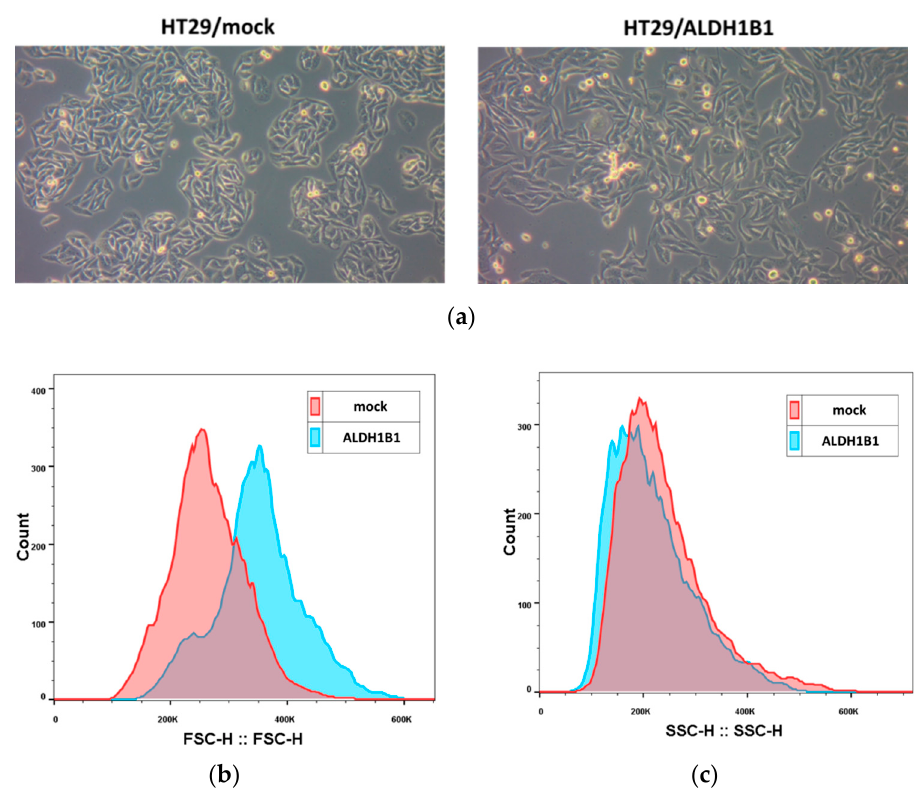
Figure 2. Expression of ALDH1B1 triggers significant morphological alterations in HT29 cells. ( a ) Photographs of the HT29 isogenic cell line pair demonstrating the morphological differences under optical microscopy (magnification 20×). ALDH1B1-overexpressing cells have different sizes ( b ) and granularity ( c ) compared to mock control cells. At least 20,000 events were analyzed through flow cytometry, and the median fluorescence intensity of forward scatter (FCS) and side scatter (SSC) parameters was determined in both cell lines (Table 2). Representative histograms of FSC ( b ) and SSC ( c ) of the HT29 isogenic cell line pair. The HT29/ALDH1B1 histogram (light blue color) had appreciably right-shifted forward and left-shifted side scatter, demonstrating the bigger size and lower granularity of ALDH1B1-overexpressing cells in comparison to HT29/mock cells (pink color). Graphs are representative of three independent experiments performed under each experimental condition. Table 2. Median fluorescence intensity for forward scatter (FSC) and side scatter (SSC) parameters. Parameter HT29/mock HT29/ALDH1B1 Statistical Significance Median